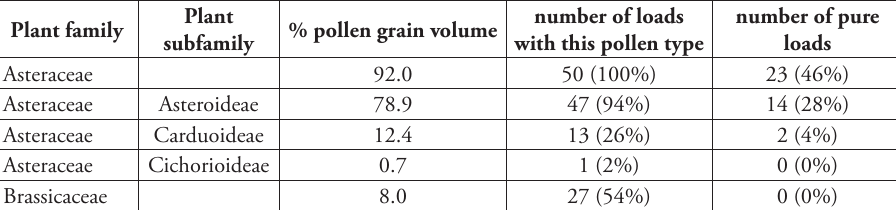
Table 2. Pollen composition of female pollen loads of Wainia eremoplana . n = 50 pollen loads from 21 different localities in Israel and Palestine (n = 47), Jordan (n = 2) and Tunisia (n = 1). Plant